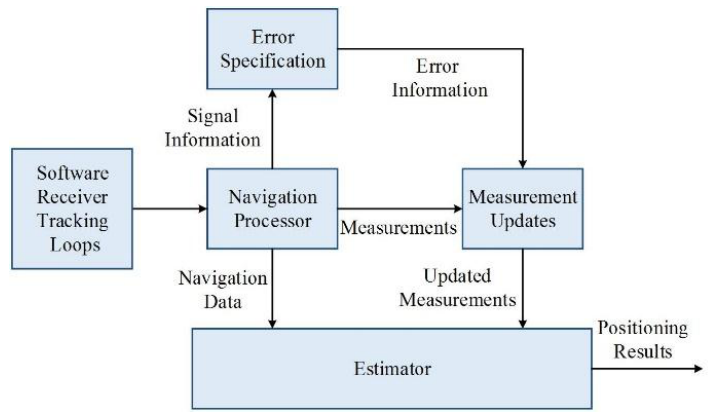
Figure 6. Flowchart of observation error simulation in true navigation data.